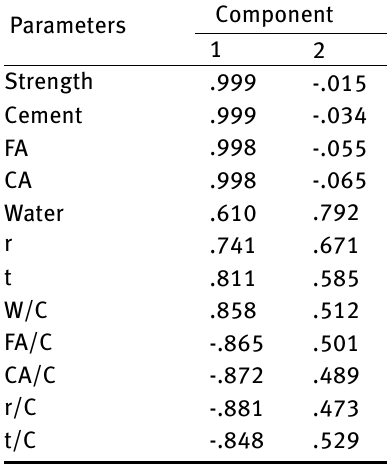
Table 3: Component Matrix using the Extraction Method, Principal Component Analysis